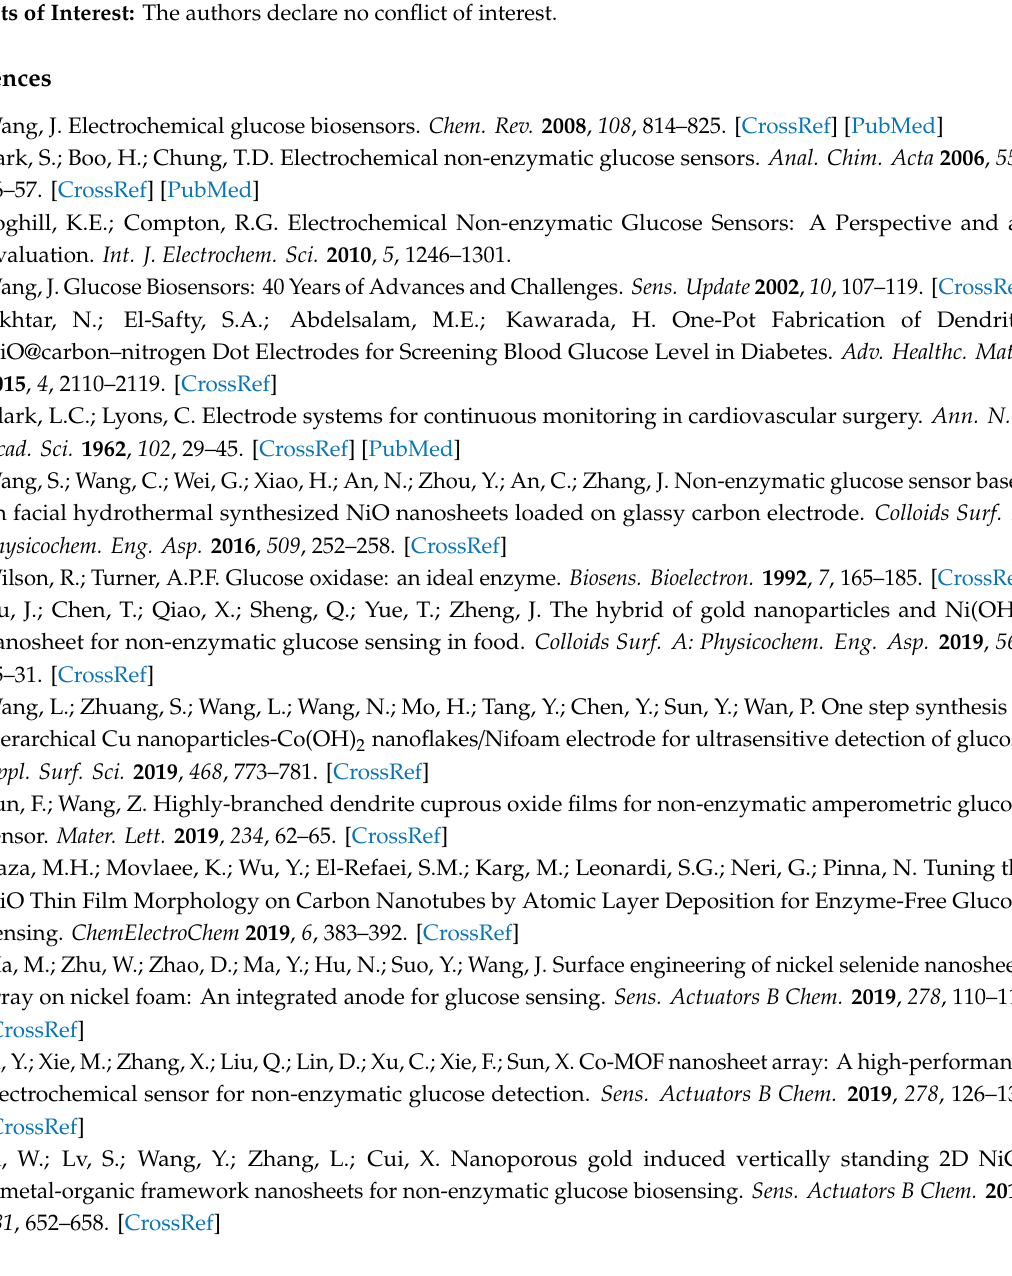
e ff ective approach for the development of other highly e ffi cient electrode materials for nonenzymatic glucose sensors. Figure S1: The TEM images of (a) Co(OH) 2, (b) Ni 0.3 Co 0.7 (OH) 2 , (c) Ni 0.5 Co 0.5 (OH) 2 , and (d) Ni(OH) 2 hollow cubes; Figure S2: Cyclic voltammograms plots of di ff erent Ni x Co 1-x (OH) 2 / CP at various scan rates (10–50 mV s − 1 ) scan in the non-Faradaic potential